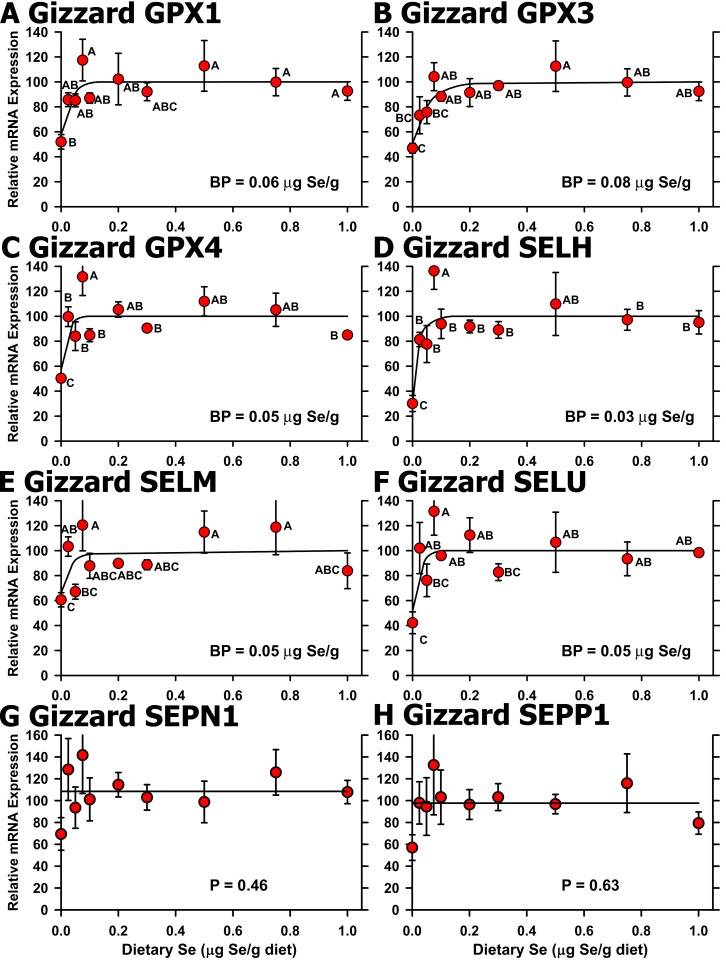
Effect of dietary Se on selenoprotein transcript level in chick gizzard.Relative transcript levels are plotted for GPX1 (A), GPX3 (B), GPX4 (C), SELH (D), SELM (E), SELU (F), SEPN1 (G), and SEPP1 (H) in chicks supplemented with the indicated levels of dietary Se for 29 d. Values were determined in triplicate for each sample, normalized to the mean of GAPDH and ACTB levels in each sample, expressed as a percentage of Se-adequate plateau levels, and plotted as mean±SEM (n = 3-4/treatment). For panels A-F, means without a common letter are significantly different (P<0.05). Overall level of significance, as determined by ANOVA, is given in Table 3. Se response curve breakpoints (BP) are indicated in each panel, calculated as described in the text. For panels G and H, overall level of significance, as determined by ANOVA.